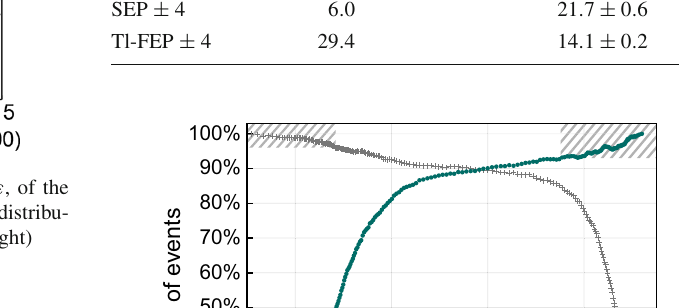
from the original pulse is contained in the reconstruction. For ε = 1, the reconstruction error is equivalent to the deviation expected from noise only.